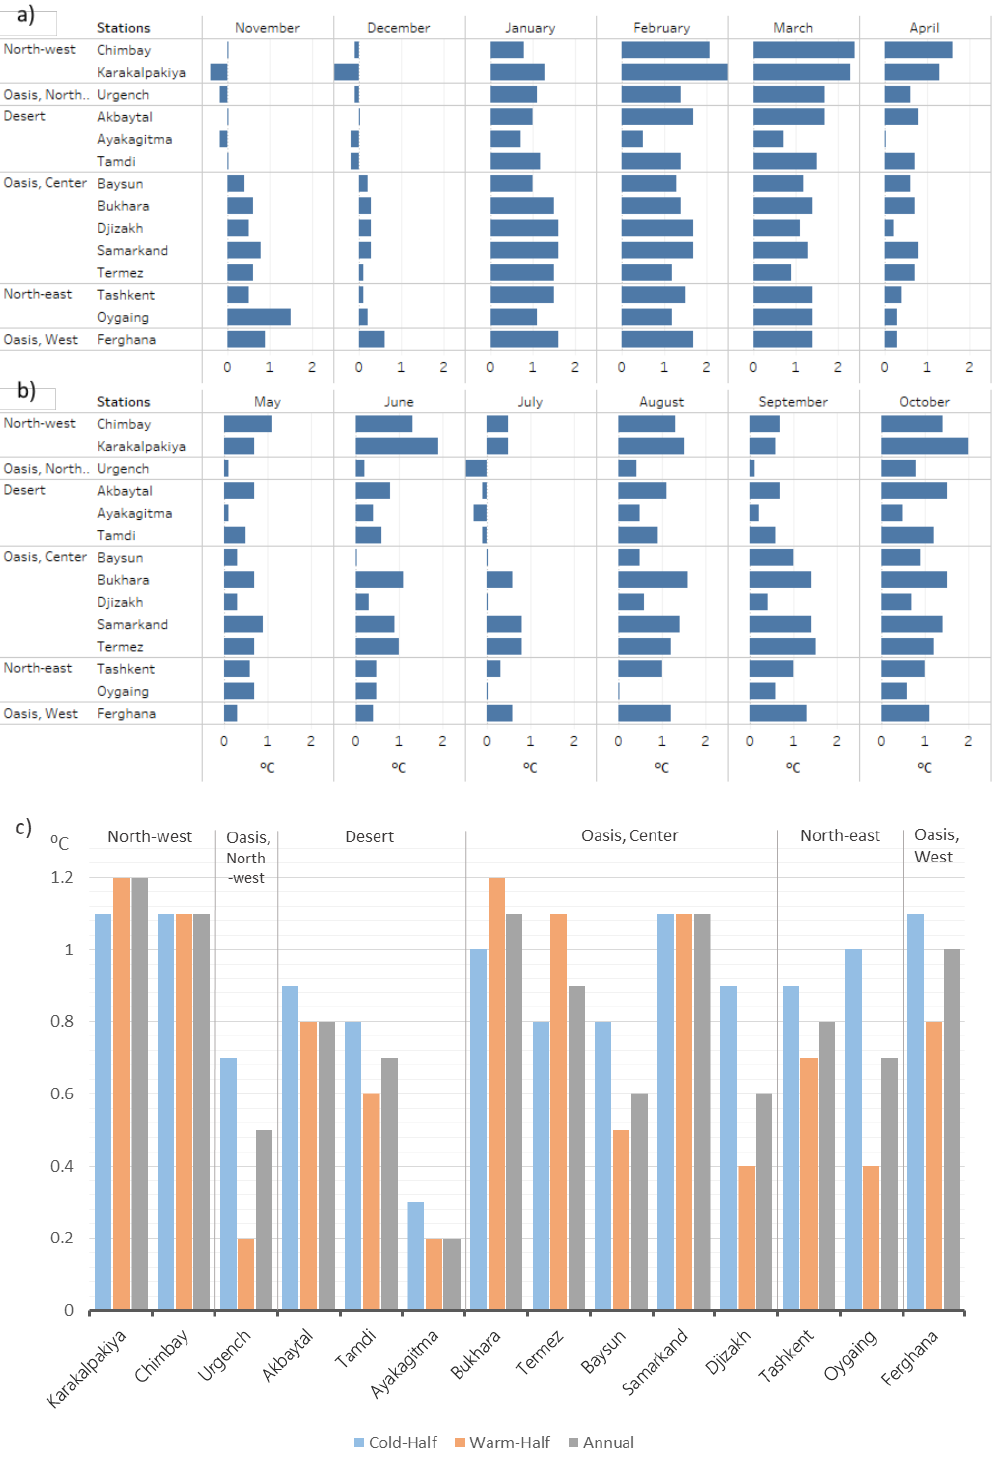
Figure 3. Long-term mean air temperature ( ◦ C) increment compared to the baseline period over representative stations (see Appendix A: Table A2). Monthly long-term mean air temperatures for ( a ) the cold half-year; ( b ) the warm half-year; ( c ) annual, cold and warm averages. The extent of temperature variations in all 69 meteorological stations over the territory of Uzbekistan on long-term mean temperatures for the entire observation period (1991–2016) compared to the baseline period (1961–1990) is shown in Figure 4.